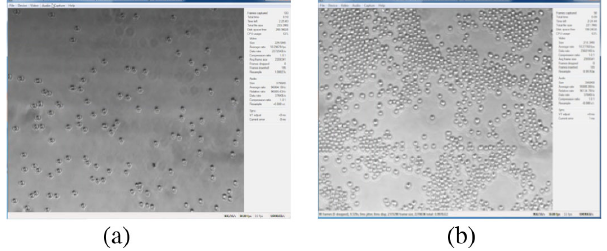
FIG. 2. Screen captures of group ’ s 100 × sample, from which Lisa begins recognizing a procedural inconsistency. (a) Screen capture of group ’ s 100 × sample shortly after pipetting and (b) screen capture of group ’ s 100 × sample after several